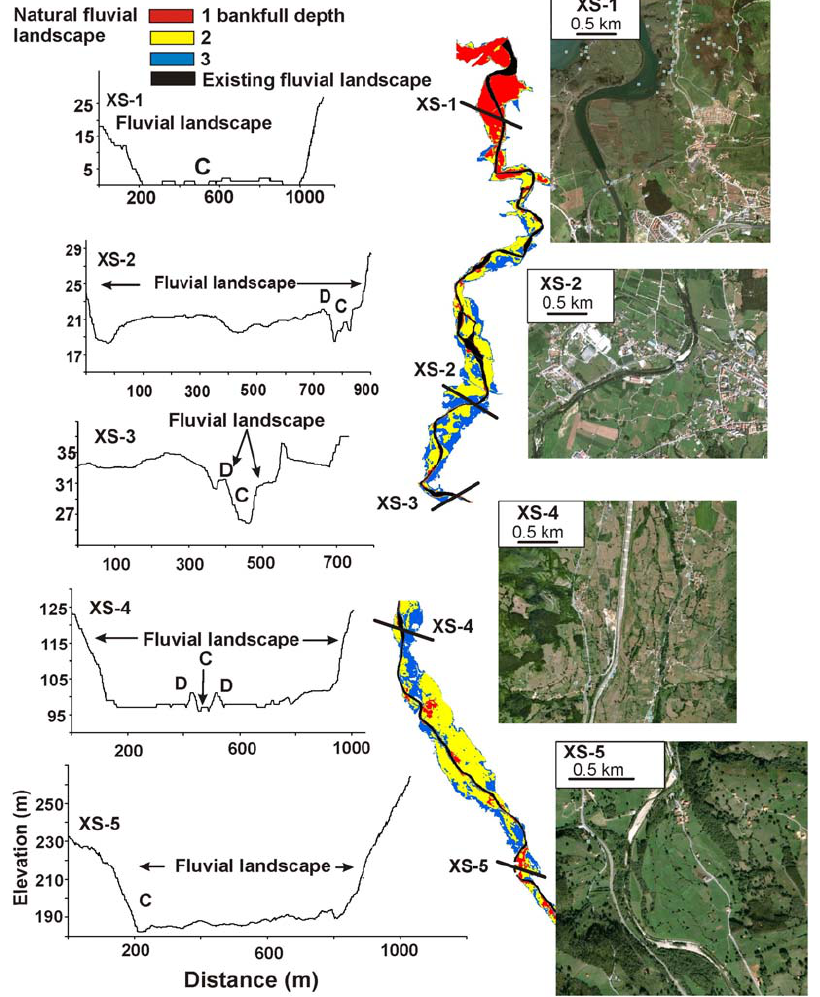
Fig. 5. Across-valley elevation profiles show the location of the predicted fluvial landscape with associated satellite images (Google Earth). The narrow, present day extent of the fluvial landscape (e.g., channel and floodplain) is denoted by “C”. Elevated surfaces that are considered to be levees are denoted by “D”. The fluvial landscapes depicted in the cross sections correspond to elevations associated with two bankfull